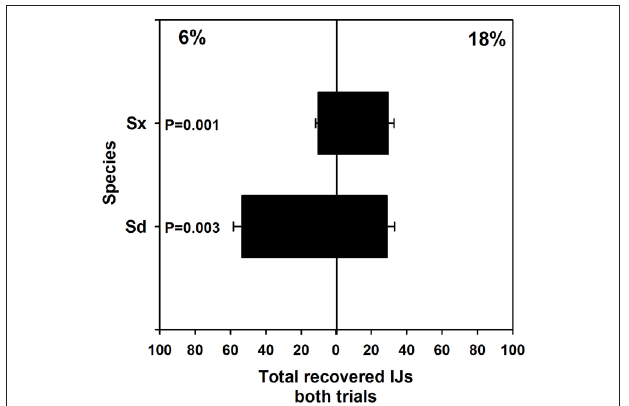
FIGURE 1 | Mean (and standard error) number of infective juvenile Steinernema sp. and S. diaprepesi recovered from the field capacity (6%) or saturated (18%) ends of soil columns with moisture gradients. Nematodes were recovered 24h after placement in the center of the horizontal sand columns. Sd , Steinernema diaprepesi , Sx, Steinernema sp.